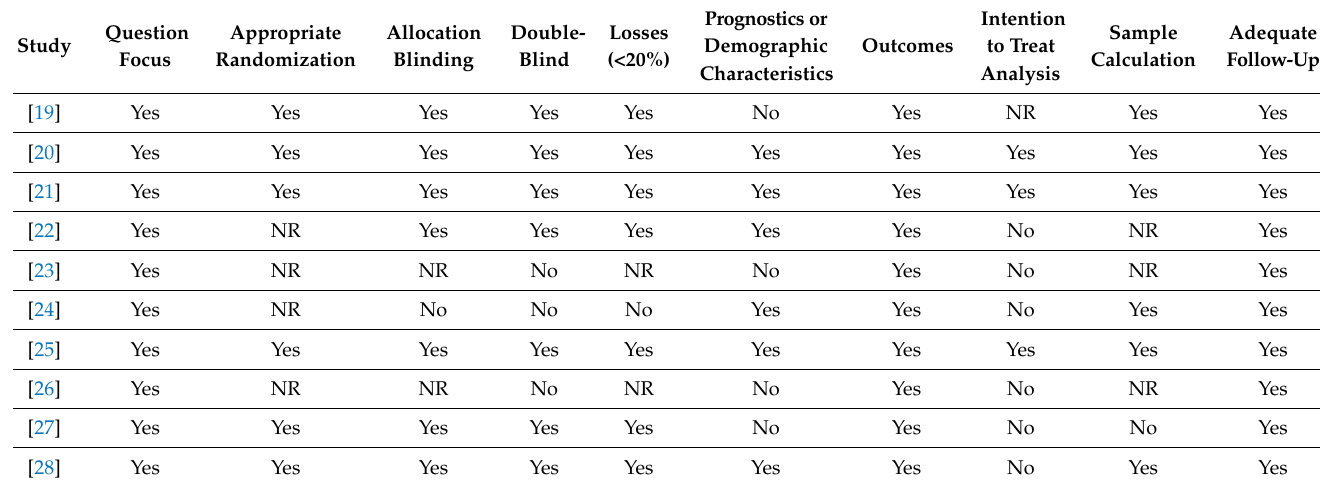
Table 2. Descriptive table showing the biases of the included randomized clinical